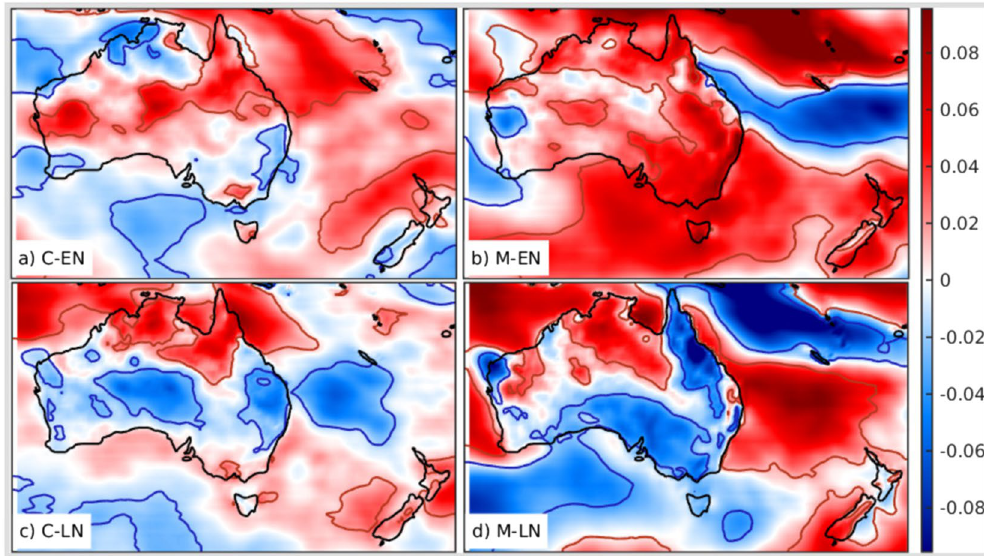
Figure 2. Composites of WPD anomalies: The mean standardized anomalies of WPD corresponding to ( a ) C-EN, ( b ) M-EN, ( c ) C-LN, and ( d ) M-LN. Red (blue) contours show regions with statistically significant increase (decrease) at 90% significance level. The unit along the colorbar is standard deviation. The figure including the map and all the text elements has been plotted in MATLAB version